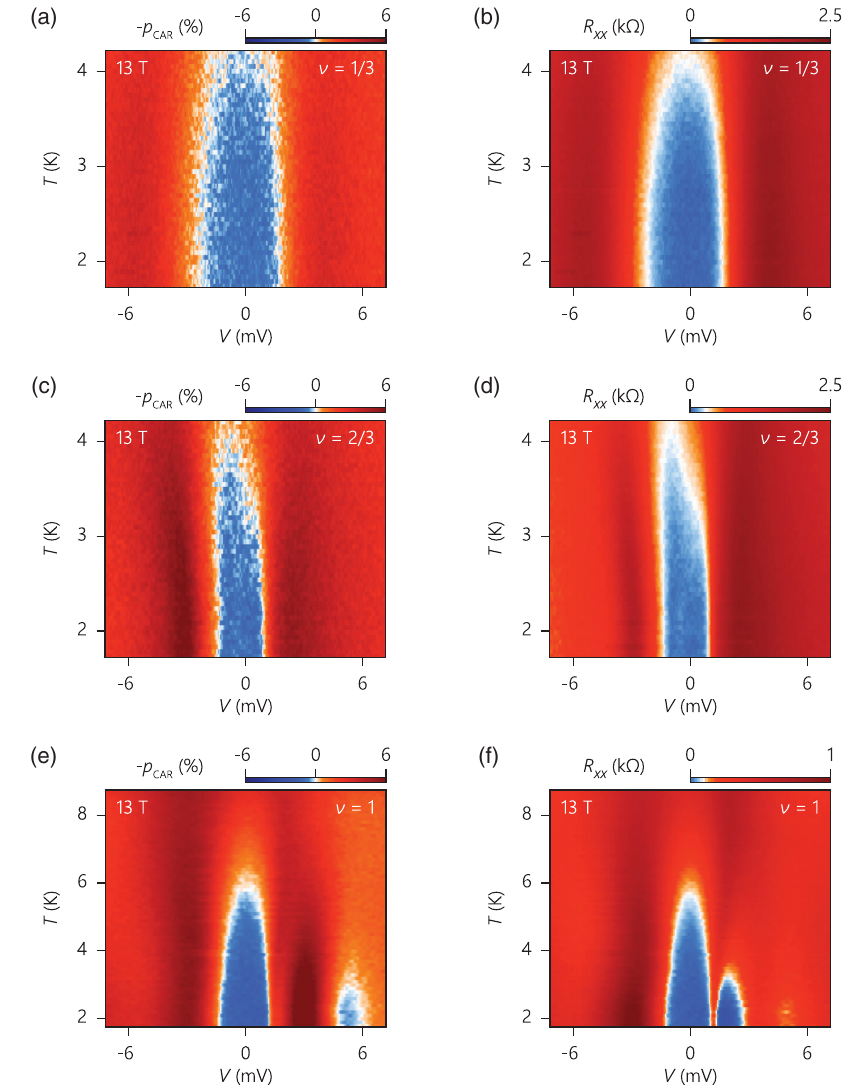
FIG. 12. Transport spectroscopy in device 2 (part 2). (a) – (f) p potential V (excitation) for different temperatures T . Crossed Andreev reflection ( R for ν ¼ 1 = 3 and 2 = 3 , and T ∼ 6 K for ν ¼ 1